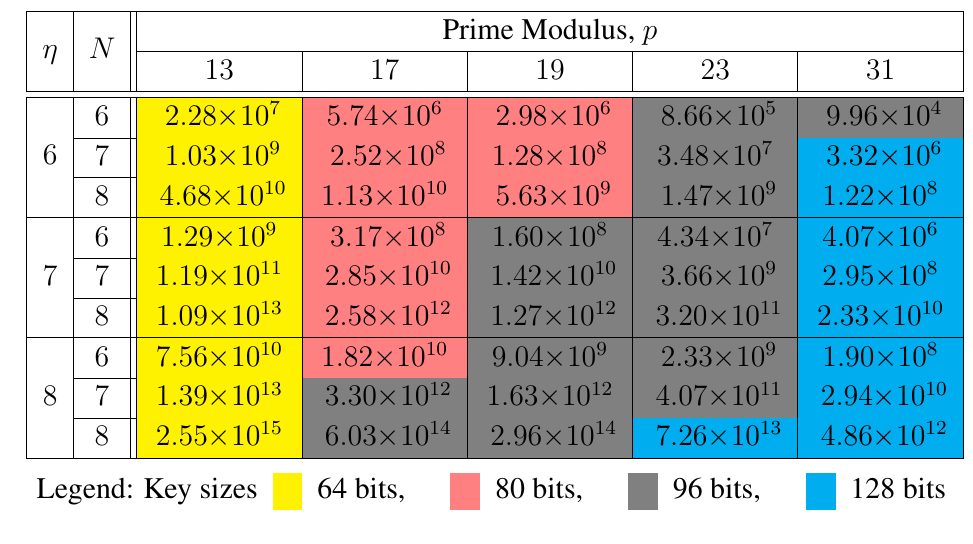
to find a traitor c